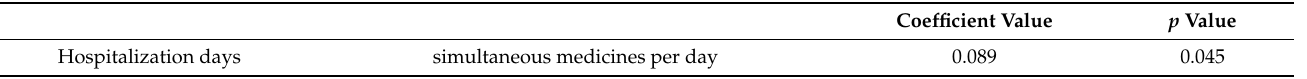
Table 5. Spearman correlation between the variables of hospitalization days and simultaneous medication per